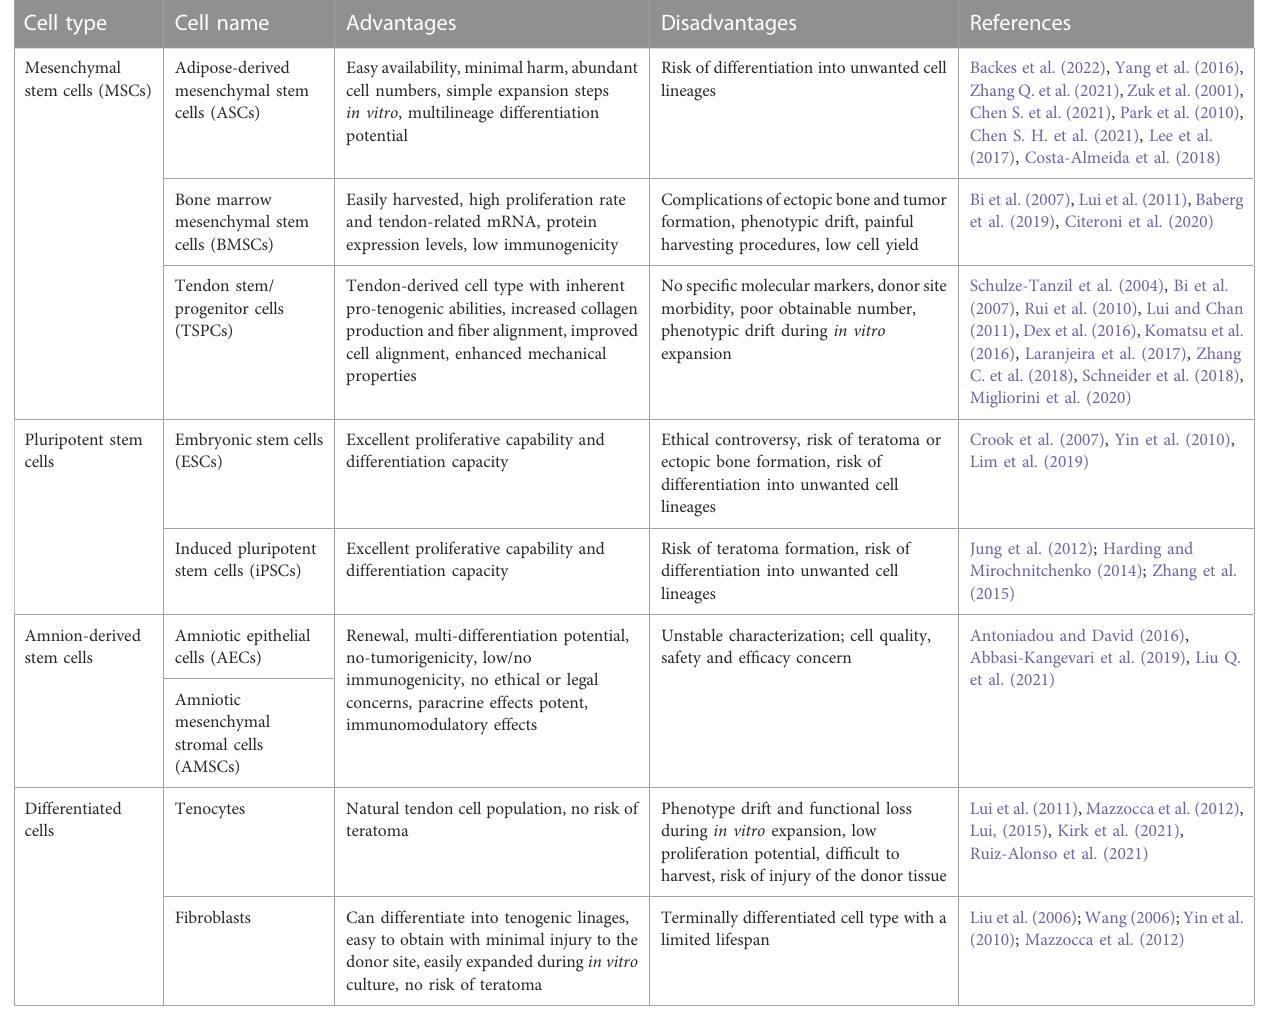
TABLE 2 Summary of the main advantages and disadvantages of the cells used for tendon tissue